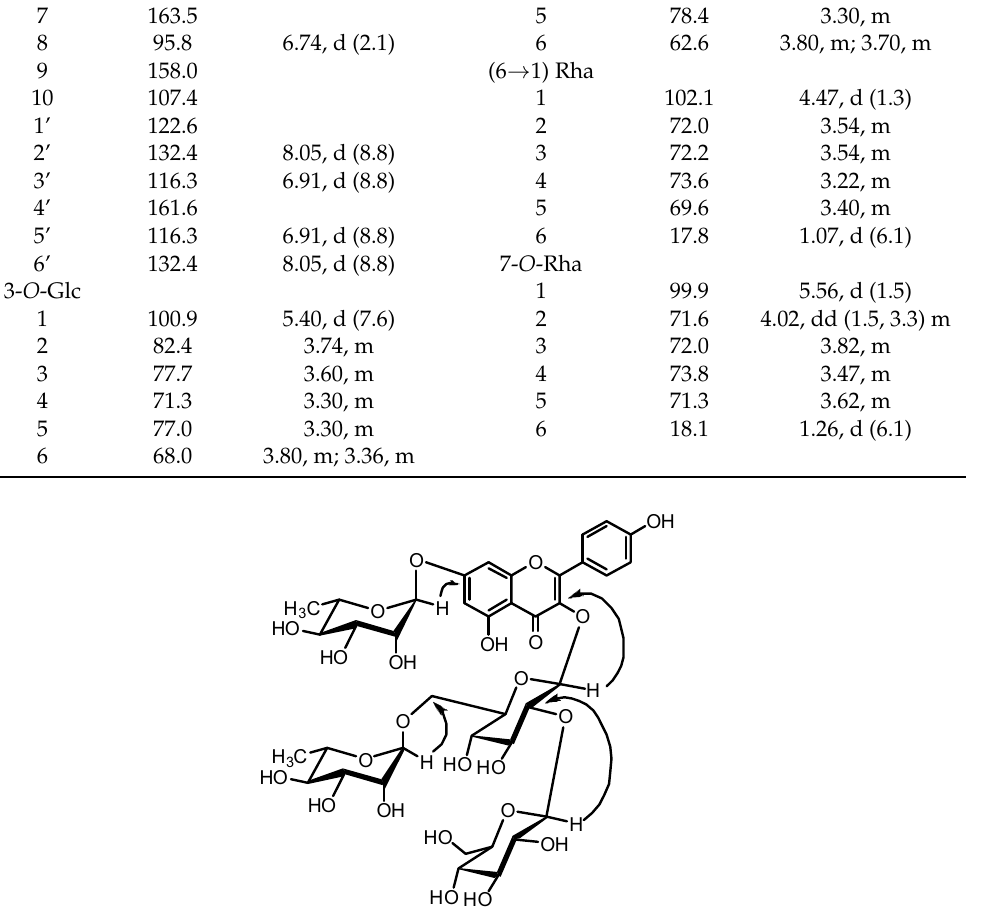
Figure 2. Key HMBC correlations of compound 1 .